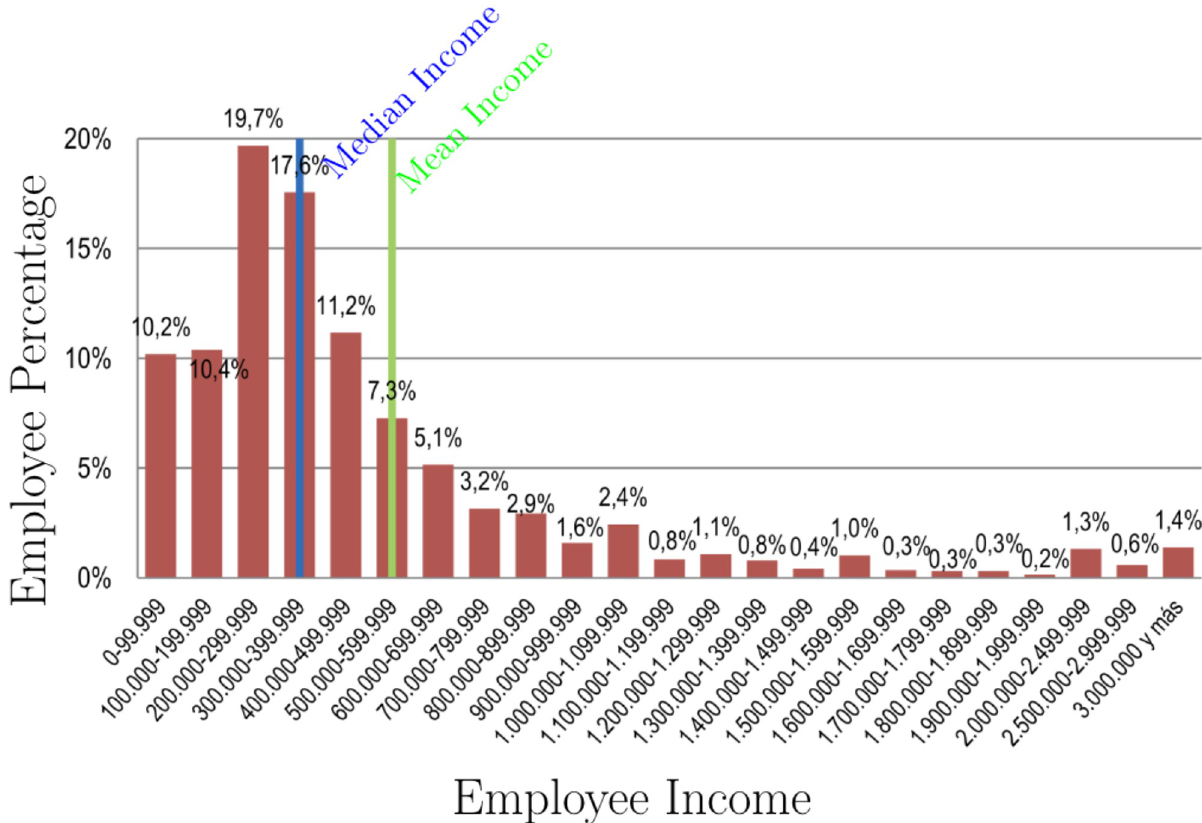
Fig 1. Employee percentage as a function of employee income. The mean income is between 500000 and 599000 CLP (Chilean pesos), while the median income is between 300000 and 399000 CLP; therefore, over 50% of the population lives on significantly less than the mean.